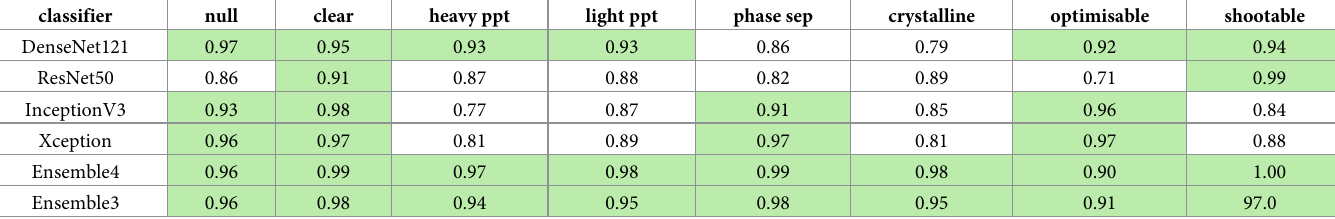
Table 4. Balanced class accuracies for Tests sets 2 and 3 combined obtained using ensemble classification in comparison to those obtained for individual classifiers. Ensemble4 combines the results of all four classifiers, whereas ensemble3 does not use the predictions from the Xception classifier. Accuracies greater than 90% are